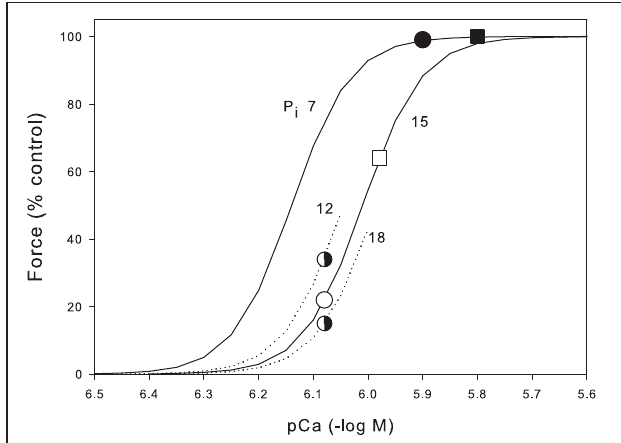
FIGURE 4 | Prediction of the force during fatigue based on the P i and Ca 2 + data from the mouse tibialis anterior. Skinned fiber data (continuous lines) is from Debold et al. (2006) and shows pCa force data at 7mM, the resting P i in mouse tibialis anterior, and 15mM, the P i reached after the standard fatigue protocol shown in Figure 3 . Black circle indicates the resting unfatigued muscle with P i 7mM and Ca 2 + assumed just sufficient to fully saturate the contractile machinery (pCa 5.9). Open circle shows the predicted force when Ca 2 + falls by 33%, as measured during fatigue, and P i rises to that observed in fatigue. The skinned fiber data predict a force of 22% under these conditions. The closed and open square show another estimated with the Ca 2 + higher by 25%. Also shown are parts of the pCa force curves for P i 12 and 18mM (see text for